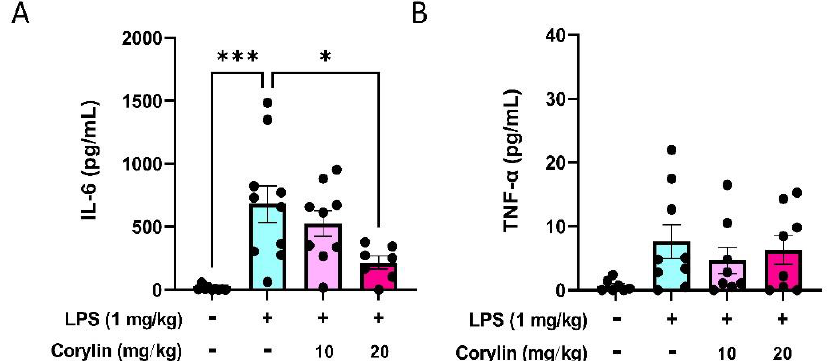
Figure 5. Effects of corylin on the expression of IL-6 and TNF- α in serum of LPS-induced mice. The expression levels of ( A ) IL-6 and ( B ) TNF- α in serum were measured using ELISA. The data are shown as mean ± SEM ( n = 7~9). (* p < 0.05 and *** p < 0.001 vs. LPS alone).